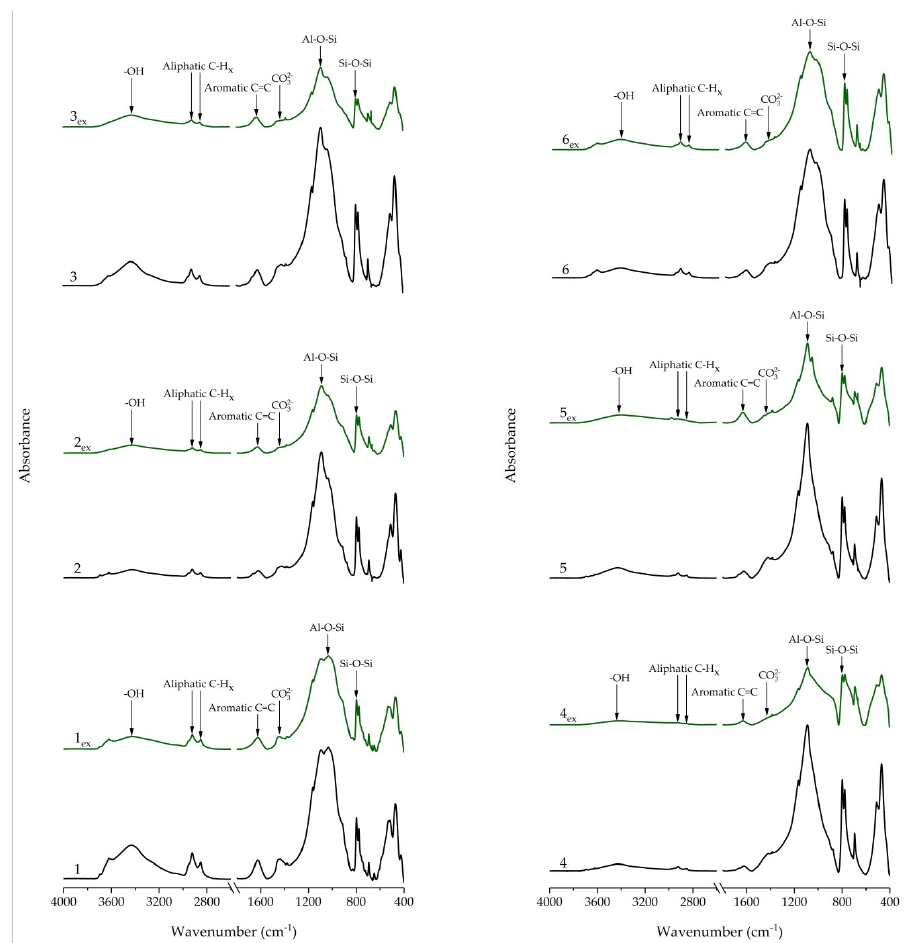
Figure A4. FTIR spectra in transmission mode of rock samples before (1–6, black) and after bitumen extraction (1 ex –6 ex , green) treated with 36% HCl (0.25% of powdered rock in KBr pellet).